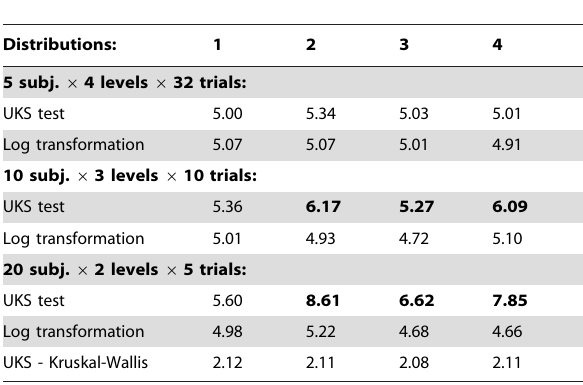
Table 3. Robustness with skewed